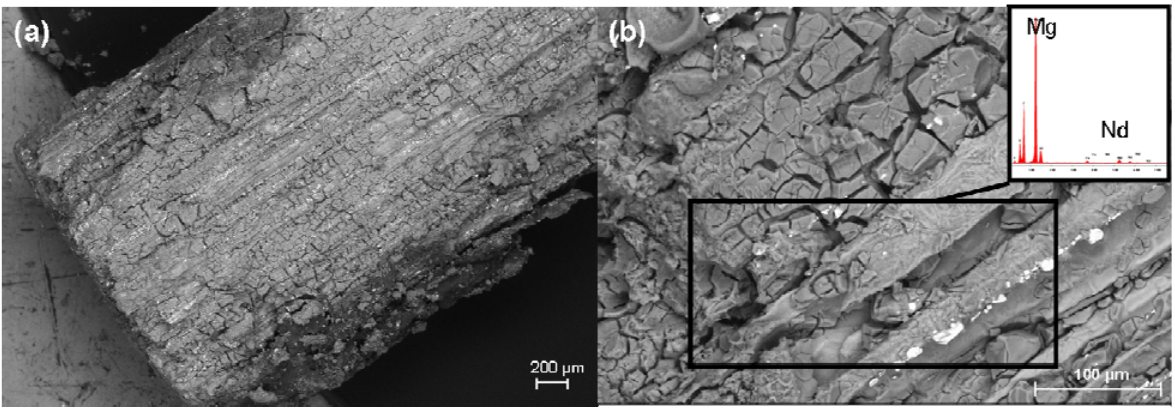
Figure 9. SEM images of the pin’s surface following hydrofluoric acid treatment, using a 26 weeks implant: ( a ) Distinct longitudinal grooves and clumpy structures; ( b ) EDX analysis: magnesium and neodymium in the grooves and clumpy